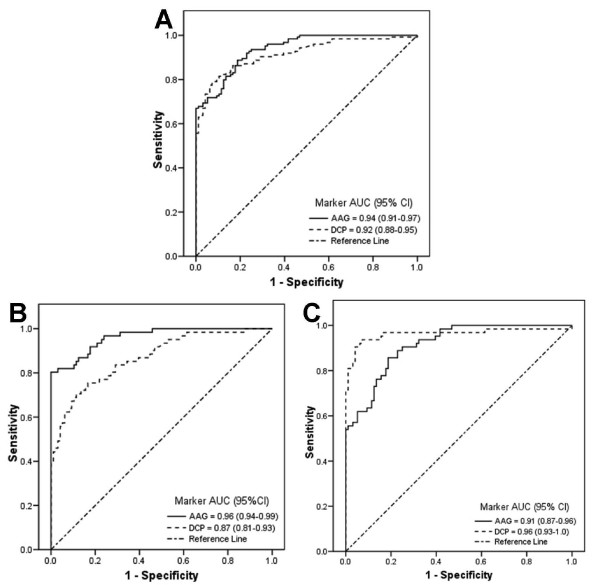
ROC curves of AAG and DCP in HCC patients. ROC curves comparing AAG and DCP in (A) all HCC patients; (B) AFP-low HCC patients; and (C) AFP-high HCC patients.